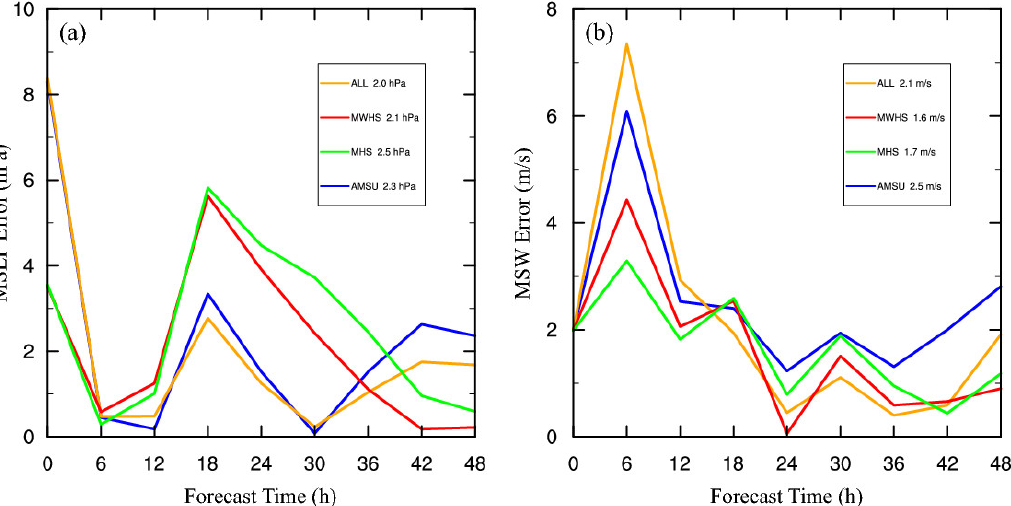
Figure 12. ( a ) The MSLP error (hPa) and ( b ) MSW error (m/s) in the 48-h forecast initialized at 0600UTC on 22 July 2018. 0600UTC on 22 July